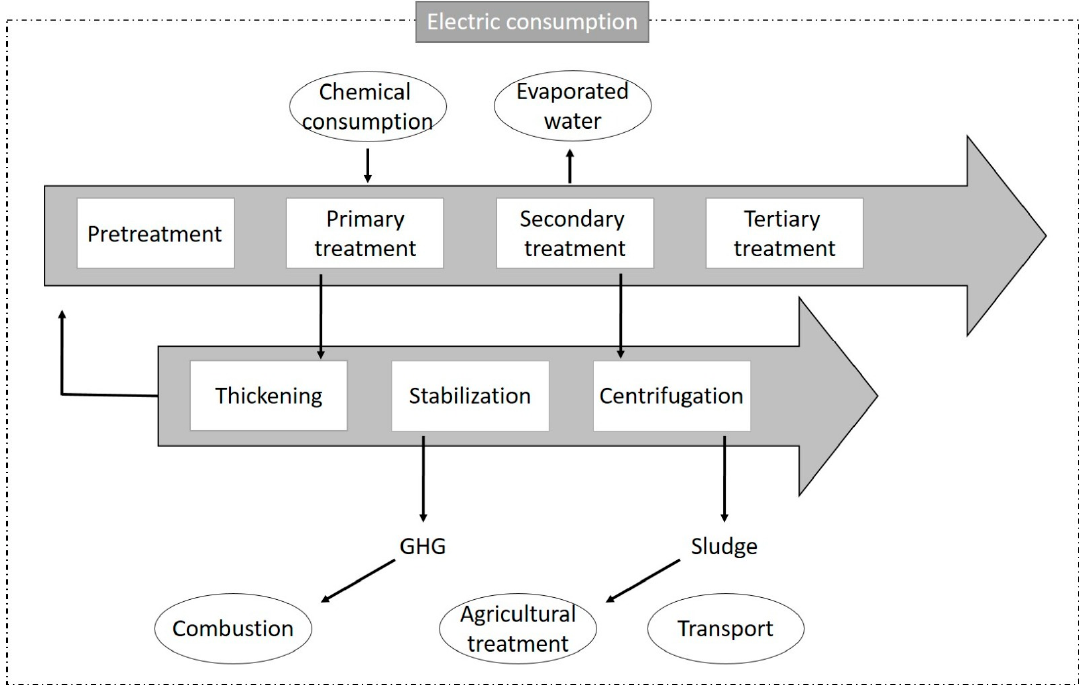
Figure 1. Scheme of supply chain of wastewater treatment plant (WWTP) for assessment of water footprint (WF) and carbon footprint (CF). Where GHG is greenhouse gas emissions.